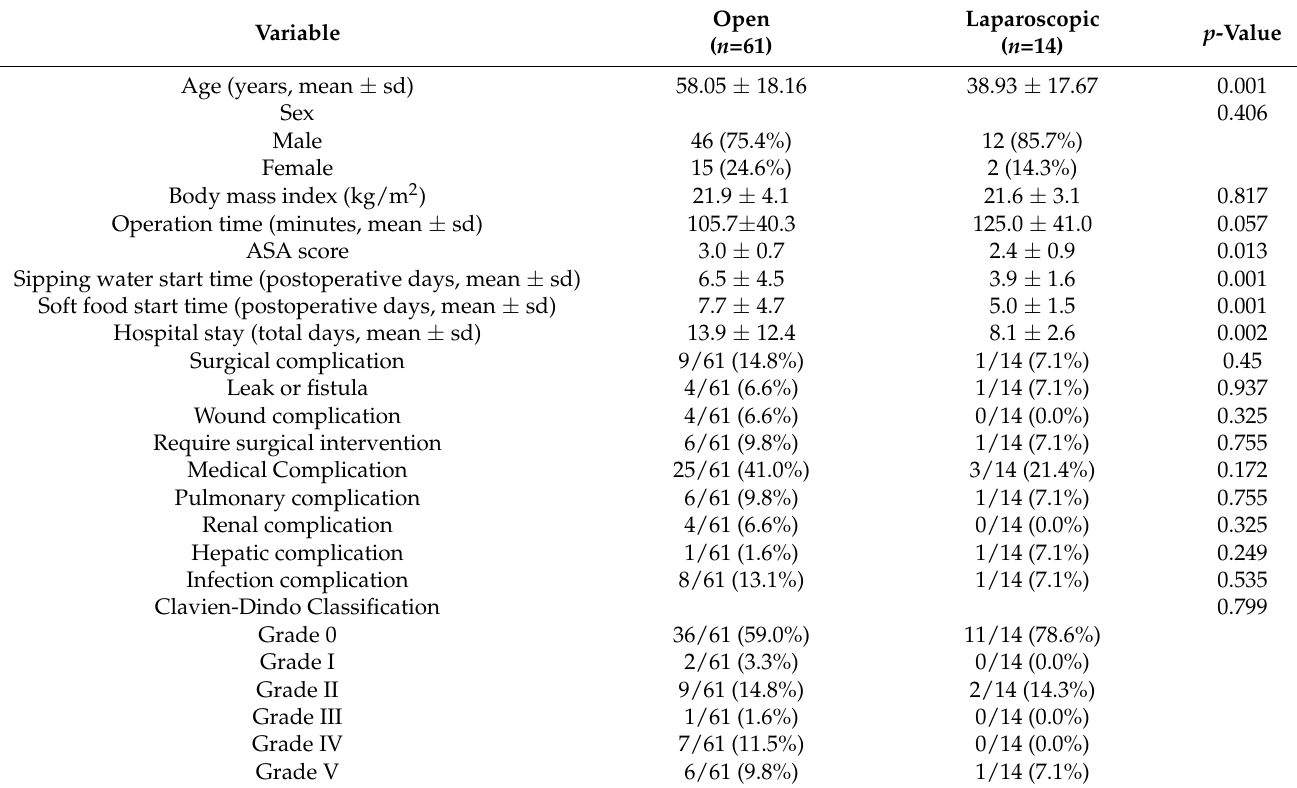
Table 5. Clinical characteristics according to surgical